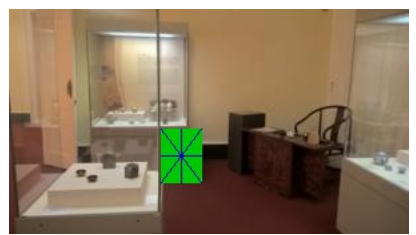
Figure 13. “Star of thickness 1 in a filled rectangle”.